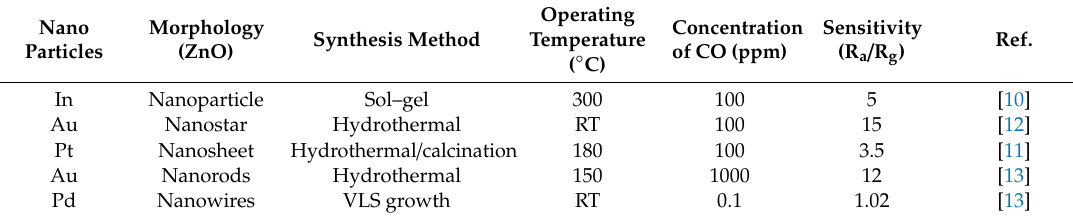
Table 1. Comparison of the CO sensitivity of metal / semiconductor gas sensors with di ff erent synthetic